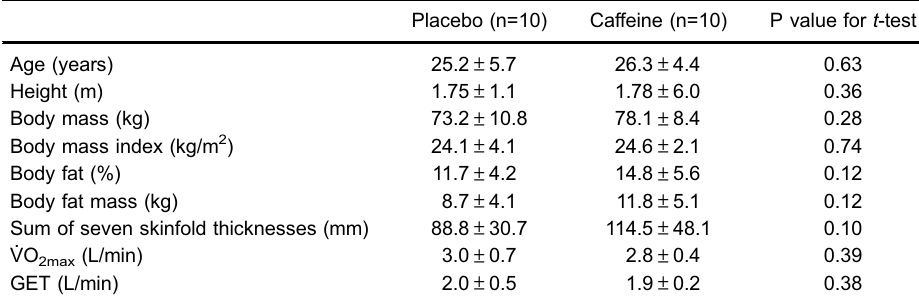
Table 1. Pre-training characteristics of the participants.